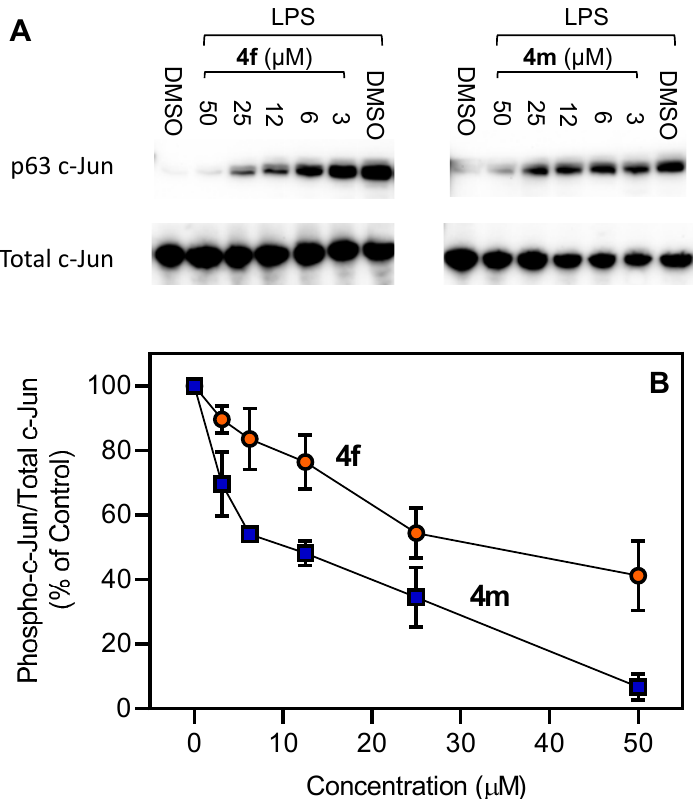
Figure 4. Effect of 4f and 4m on LPS-induced c-Jun (Ser63) phosphorylation. Human MonoMac-6 monocytic cells were pretreated with indicated concentrations of 4f or 4m for 30 min, followed by treatment with LPS (250 ng/mL) or control vehicle (1% DMSO) for another 30 min. The cells were lysed, and the lysates were analyzed by Western blotting. Total JNK (non-phosphorylated) was used as loading control for the lysates. A representative blot from two independent experiments is shown ( Panel A ). The blots were analyzed by densitometry, and the ratio of phospho-c-Jun/total c-Jun is shown in Panel B .